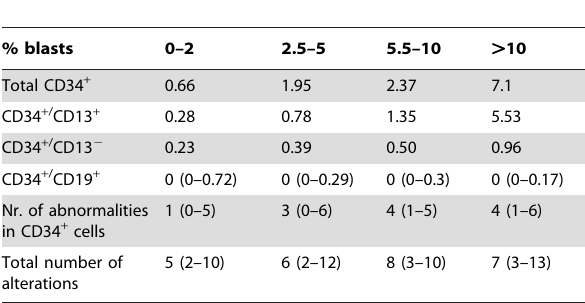
Table 4. distribution of the phenotypic abnormalities examined according to the median percentage of BM blasts in